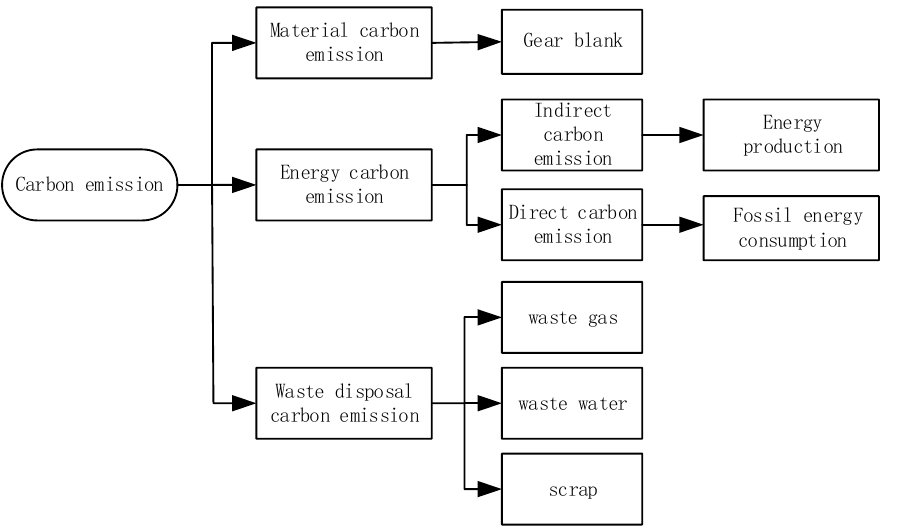
Figure 2. Influencing factors of carbon emission during gear